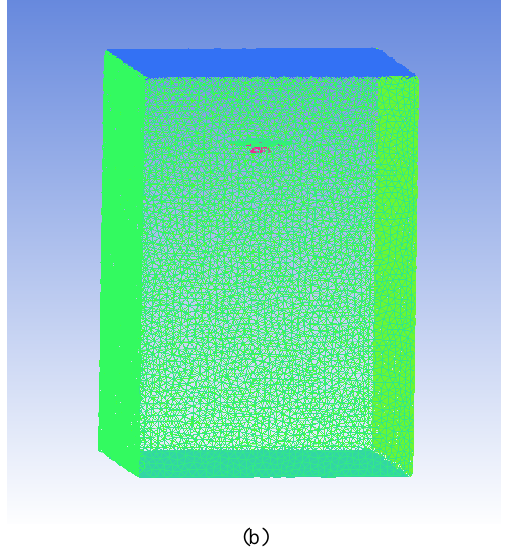
Figure 2. Model and meshing